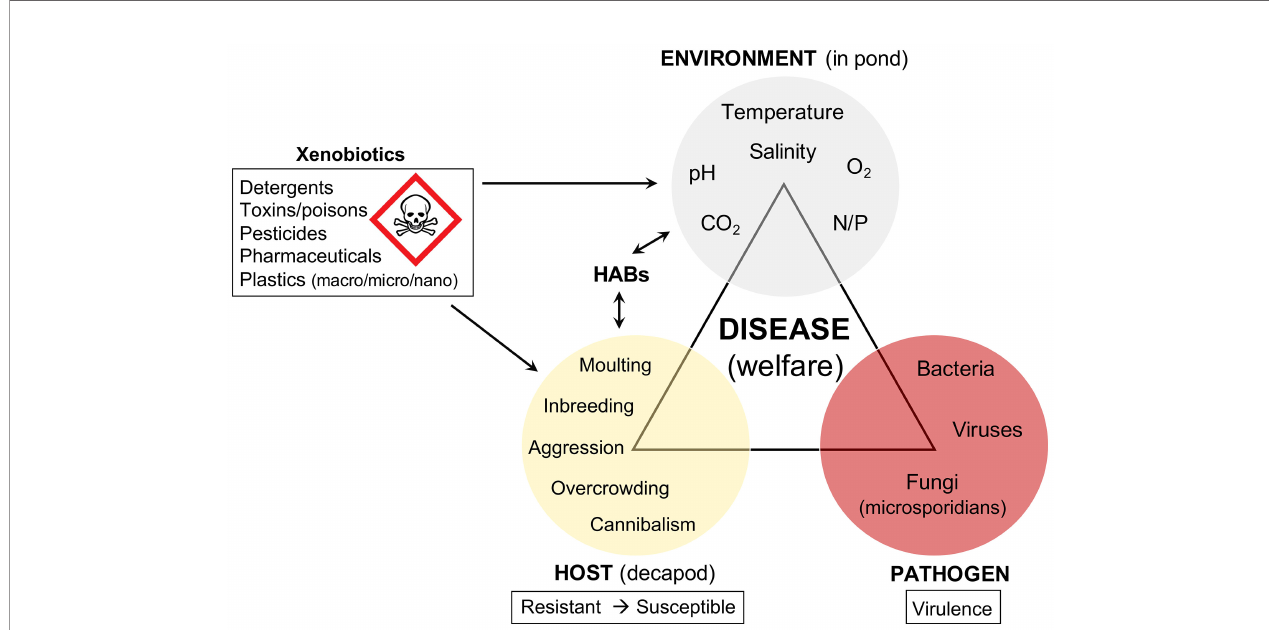
FIGURE 2 | Disease triangle in the context of penaeid welfare (in pond). Growth and maintenance of shrimp under culture conditions poses several challenges for shrimp health and welfare. Susceptible hosts, combined with virulent pathogens and unfavourable environmental conditions encourage disease outbreaks. The presence of immune-modulating xenobiotics, fl uctuating abiotic factors leading to hypoxia, hypercapnia, or acidosis can tip the balance in favour of the pathogen(s). HABs, harmful algal blooms; N, nitrogen; P,